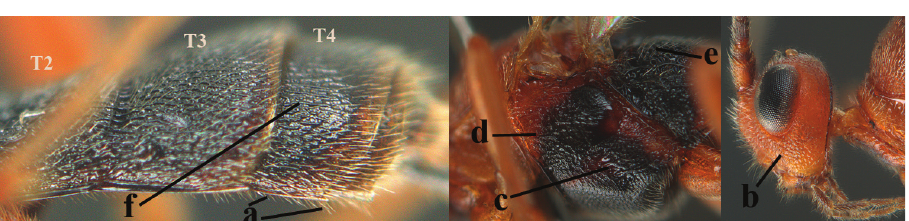
19 Fourth metasomal tergite with a more or less sharp lateral crease for its whole length (a), if weak or absent then length of malar space of female 0.5–0.6 × height of eye in lateral view (b); precoxal area distinctly (and usually coarsely) rugose me- dially (c); epicnemial area (d) and propodeum (e) coarsely rugose; fourth metaso- mal tergite at least basally distinctly sculptured (f) ..................... A. bicolor